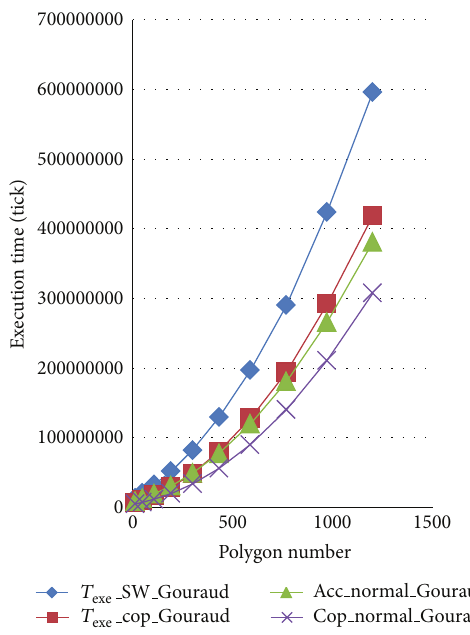
Figure 10: 𝑇 /Poly nb variation for Gouraud shading. exe